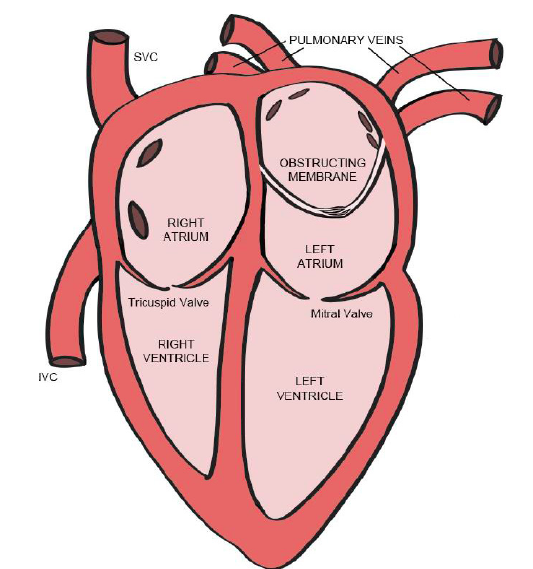
Image 1. Cor triatriatum sinister. Classic findings include a membrane separating the left atrium into two components: one chamber with the pulmonary veins and the other with the mitral valve and atrial appendage. The obstructing membrane is often partially fenestrated, allowing communication between the proximal and distal atrial segments. SVC , superior vena cava; IVC , inferior vena